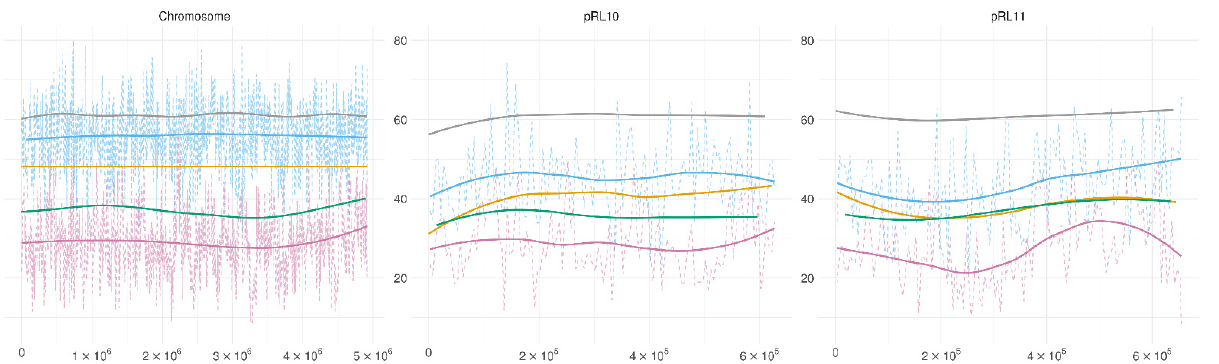
Figure 5. GATC methylation across the replicons . Green—GATC methylation in bacteroids, violet—methylation in cell culture, purple—methylation of cytosine in bacteroids, blue—methylation of cytosine in bacteroids, grey—GC content. Solid lines—polynomial regression lines calculated using the ggplot_smooth “loess” method, formula “y~x”, dotted lines—the average methylation across a 5 kb sliding window. 4. Discussion Using Oxford Nanopore sequencing technology, the genome of the Rhizobium legu- minosarum strain RCAM1026 was investigated in two different states—free-living cells, and terminally differentiated bacteroids. The analysis did not show any large-scale ge- nome rearrangements (in-dels, transpositions, or loss of replicons) taking place during terminal differentiation of cells. However, the genome coverage analysis showed signifi- cant differences in the relative abundances of replicons between the investigated states. The lower observed copy number of the symbiotic plasmid in free-living culture illus- trates the relative ease with which the strain loses its symbiotic plasmid when propagated on solid media without the signals from a possible host for a prolonged period of time. The observed phenotype may be a naturally occurring population structure in which only a part of the population carries the plasmid, making the whole population more resistant to the changing environmental conditions [40]. The equalization of the plasmid copy number in the bacteroids is to be expected, as only the cells possessing the full array of symbiotically critical genes should be able to enter the symbiotic state. The relatively higher coverage of the chromosome observed is similar to the observation made by George C. diCenzo et al. in [17], where a similar pattern was described for the replicons in the bacteroids formed by Ensifer bacteria. Although the observed coverage should be in direct relation with the chromosome copy number in free- living cells and bacteroids, the differences in DNA content in the bacteroids need to be verified directly in further studies. The exact reason behind this abundance variation is unclear; one possible explanation is that the preferential replication of the chromosome makes it possible for the bacteria to increase the transcription of important metabolic genes by increasing the number of gene copies in the cell.